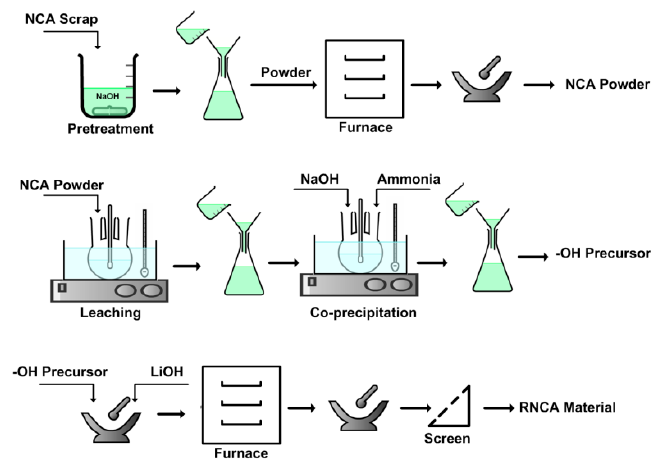
Figure 1. Flow chart of the recycled Lithium Nickel Cobalt Aluminum Oxide (RNCA) recycling process.